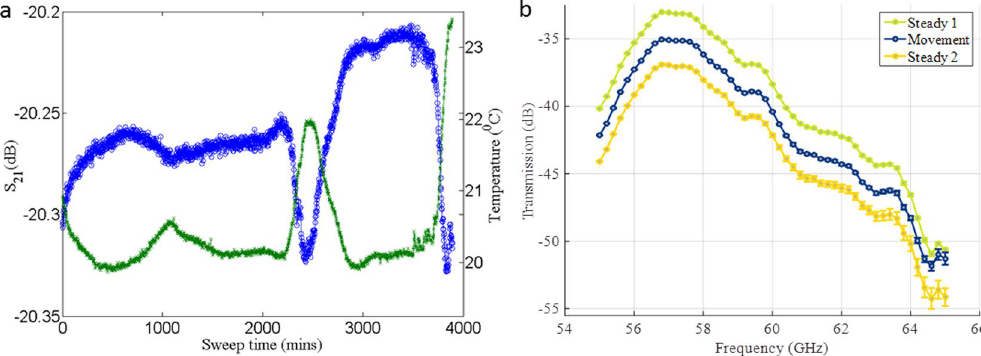
Figure 4. The effect of environmental factor on measured data. ( a ) The variation in S 21 and temperature for a 20 dB attenuator recorded over a two days period. ( b ) The effects of vibration (movement) on the S 21 through a 3-1-3 tank using phase-stable cables. The curves have been offset from the original values in the S 21 axes to better illustrate the errors introduced. Steady state 1 and 2 means measurement before and after